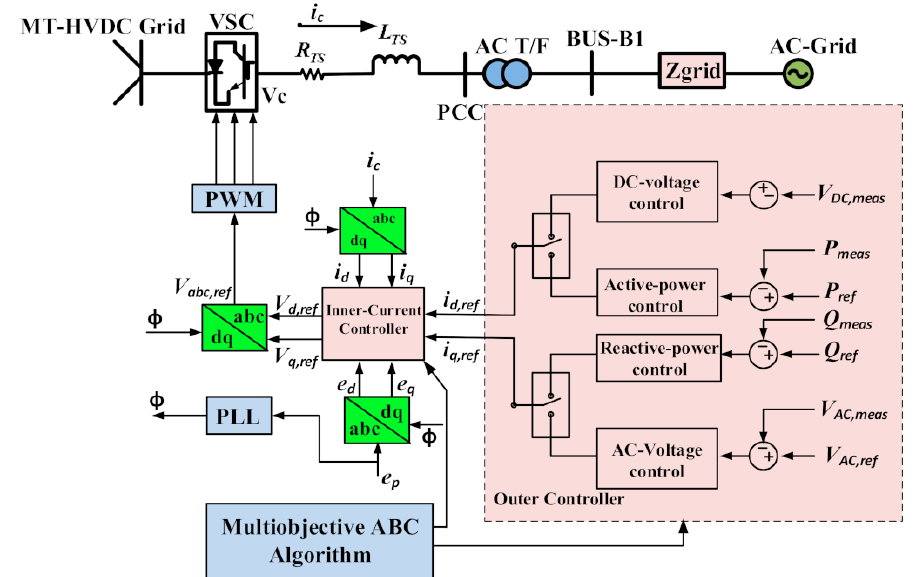
Figure 9. ABC-based multiobjective tuning of Voltage-Source Converters (VSCs). The minimization of the compound- objective function (15) helps achieve the multiobjective function’s optimization goals. In this situation, the goal is to set a setup containing two different objective functions, (13) and (14). Each objective function’s weight evaluates a compromised function, while the weight selection describes each element’s significance in (16). Therefore, the overall objective function represents as: